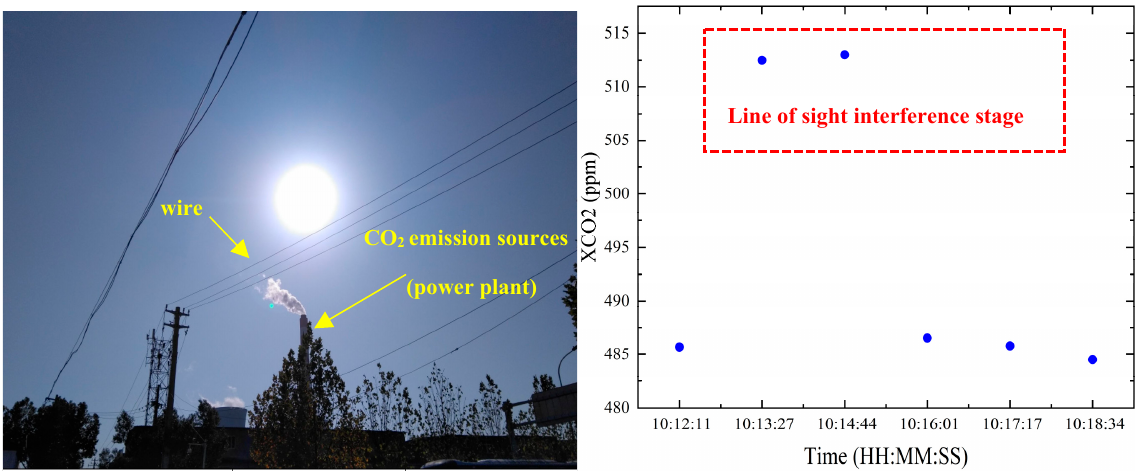
Figure 17. Line of sight interference ( left figure) and anomaly inversion results ( right figure).